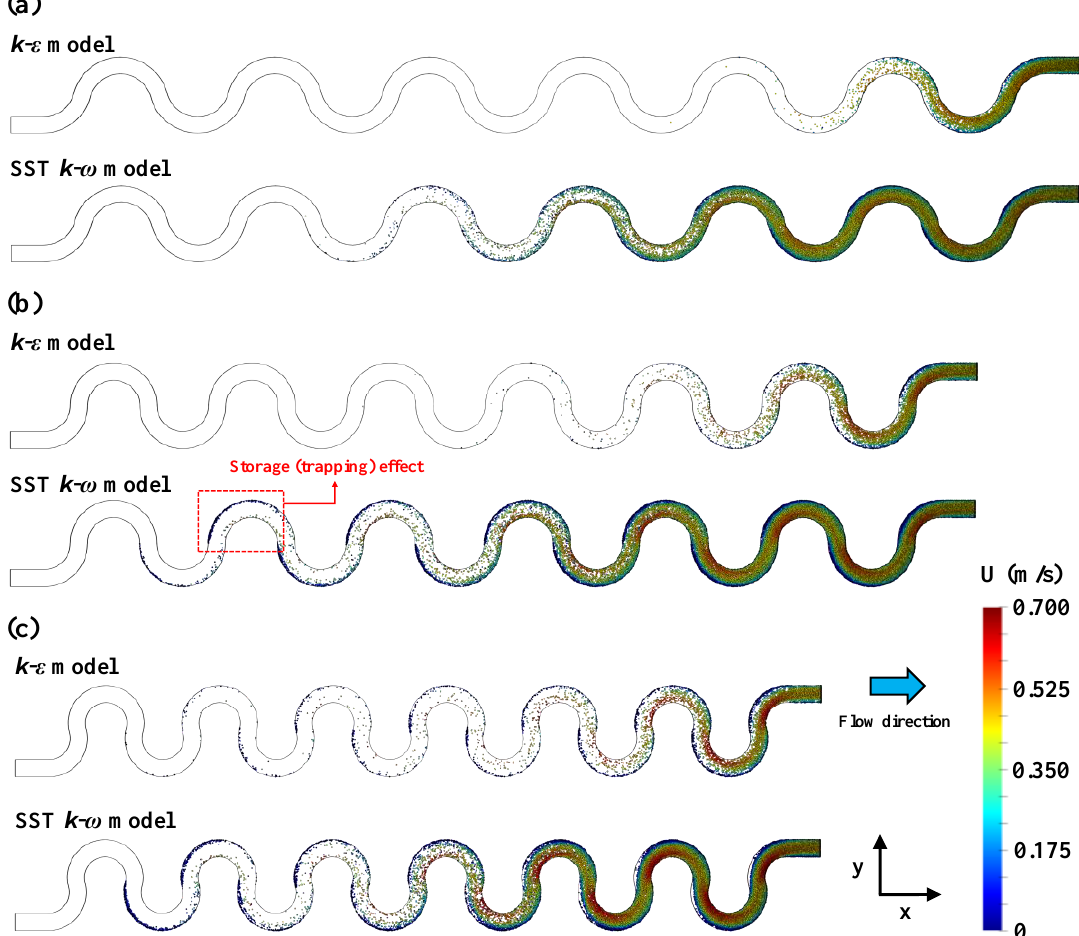
Figure 10. Particle positions for ( a ) S136, ( b ) S157, and ( c ) S190 at t = 500 s, simulated with the 3D LPT model based on flow fields obtained from the k − ε model and SST k − ω model. The colormap indicates Lagrangian velocity of particles.